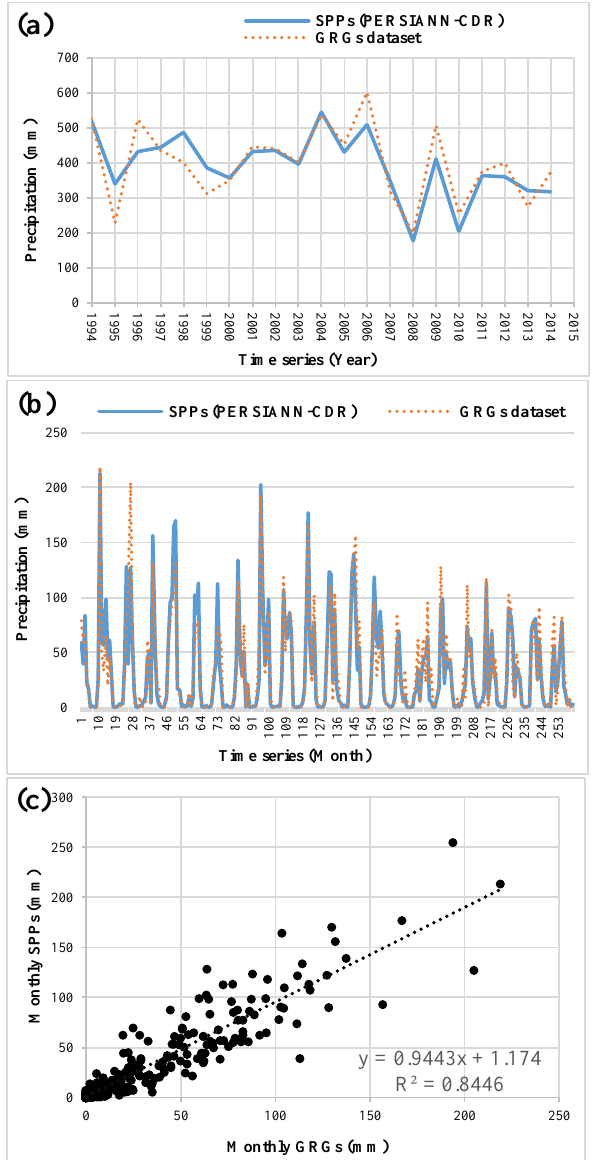
Figure 3. Comparing SPPs and GRGs datasets, (a) Annual time series, (b) Monthly time series, and (c) Time series’ correlation.